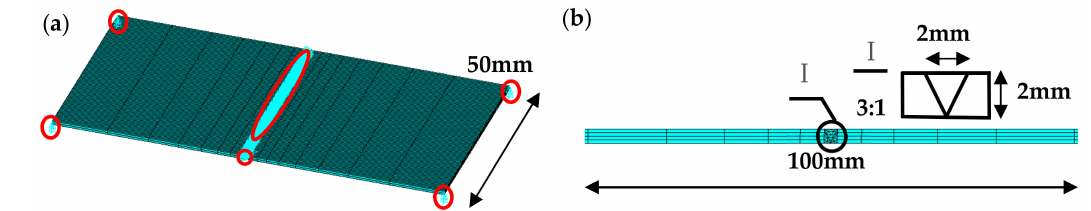
Figure 7. Displacement constraint ( a ) and mesh generation ( b ) of the finite element